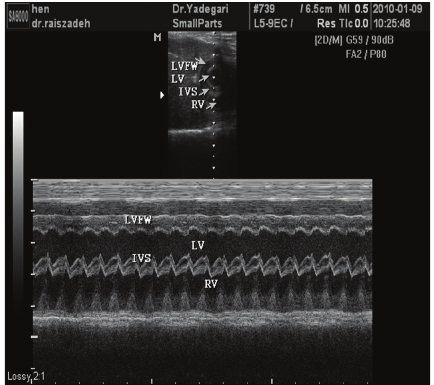
Figure 2: B-mode and M-mode echocardiography. Left ventricle (LV),rightventricle(RV),leftventricularfreewall(LVFW),andwall between the two ventricles